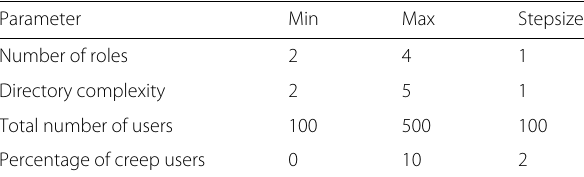
Table 3 Experimental analysis parameter variation (minimum, maximum and stepsize) Parameter